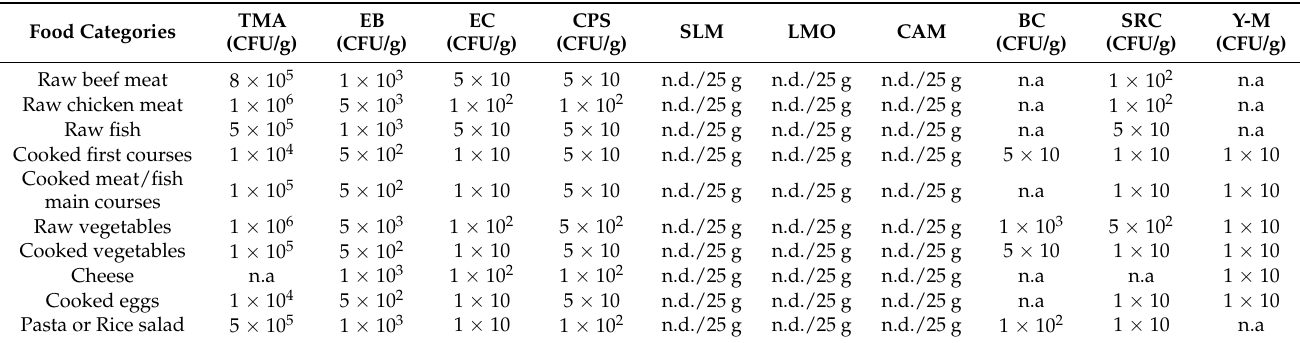
Table 2. Microbiological reference limits for food